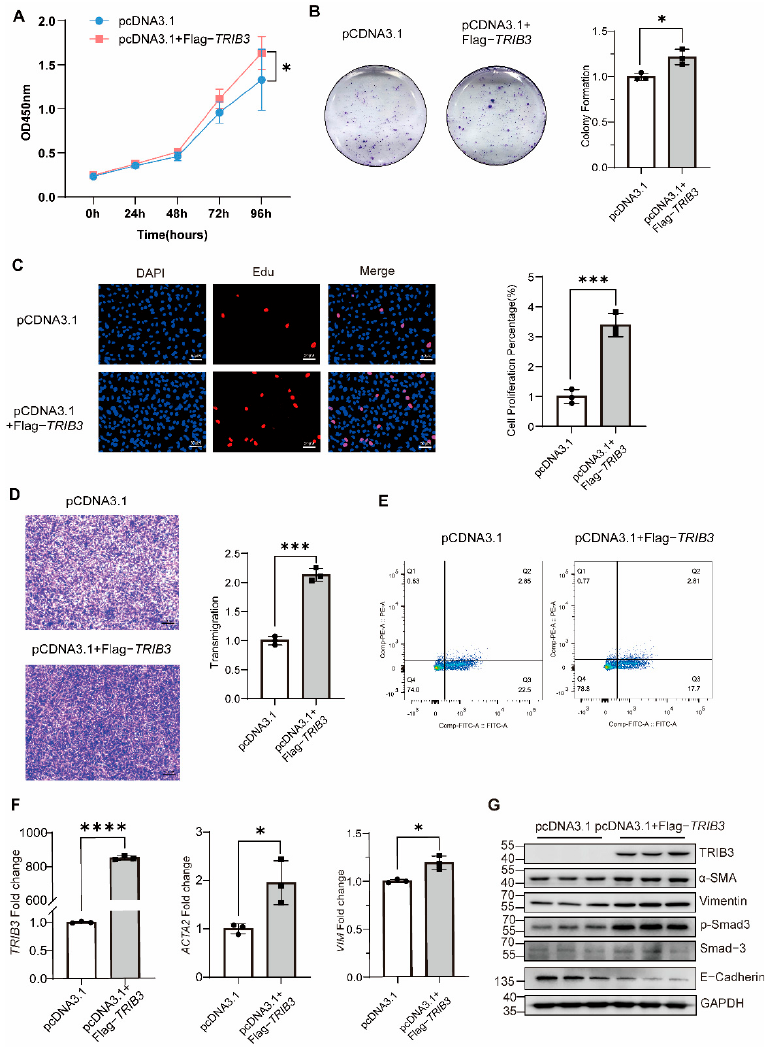
Figure 3. TRIB3 expression promoted A549 cell proliferation, migration, and profibrotic genes expression. ( A ) The effect of TRIB3 overexpression on the viability of A549 cells was assessed by CCK8 assay (N = 4 independent experiments). Significant differences between groups were evaluated by two-way ANOVA with Š í d á k’s multiple comparisons test for pairwise comparisons. * p < 0.05. ( B ) The effect of TRIB3 overexpression on the colony formation of A549 cells (N = 3 independent experiments). The results were analyzed by the unpaired Student’s t -test for comparisons between two groups with normal distribution. Data are presented as mean ± SD. * p < 0.05. ( C ) The EdU proliferation assay was used to measure A549 cell proliferation. The results were analyzed by the unpaired Student’s t -test for comparisons between two groups with normal distribution. Data are presented as mean ± SD. *** p < 0.001. ( D ) Crystal violet staining of A549 cell is shown for the transwell assay (N = 3 independent experiments). The results were analyzed by the unpaired Student’s t -test for comparisons between two groups with normal distribution. Data are presented as mean ± SD. *** p < 0.001. ( E ) Cell apoptosis measured by cytometry, with quantification analysis (N = 3 independent experiments). ( F ) Gene expression analysis by qPCR demonstrated a significant increase in TRIB3 , ACTA2 , and VIM transcript levels in TRIB3 -overexpressed normal epithelial cells. GAPDH was used as an internal control. The results were analyzed by the unpaired Student’s t -test for comparisons between two groups with normal distribution. Data are presented as mean ± SD. * p < 0.05 and **** p < 0.0001 vs. control. ( G ) Western blot analysis showed that the expression of α -SMA, vimentin, E-Cadherin, and p-Smad3 in A549 cells increased after overexpressing TRIB3 (N = 3 independent experiments). For western blot, GAPDH was used as an internal